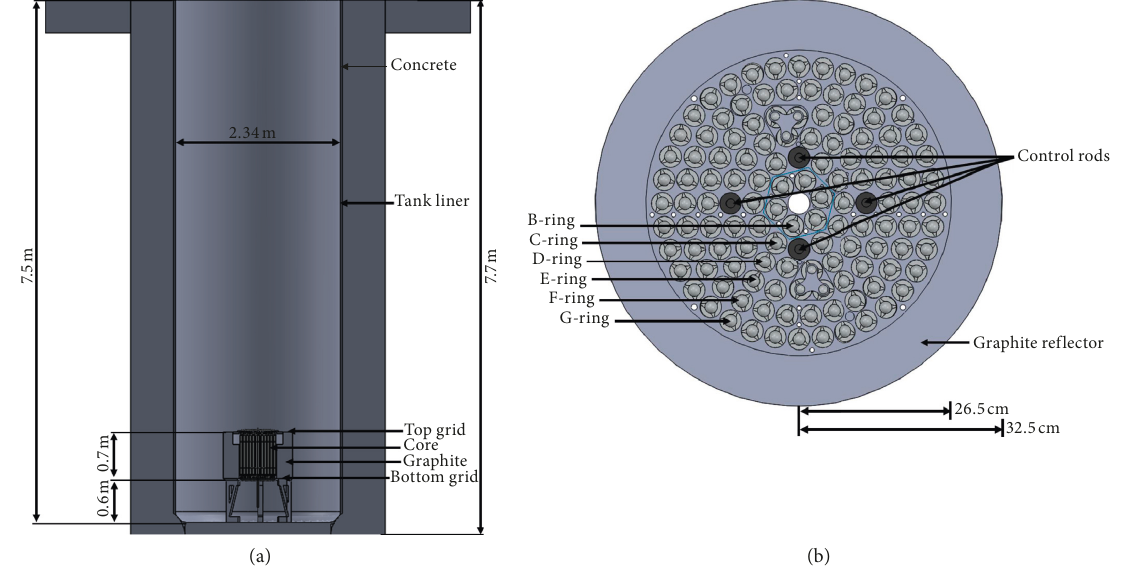
Figure 1: (a) Side view and (b) top view of the core of the GSTR.